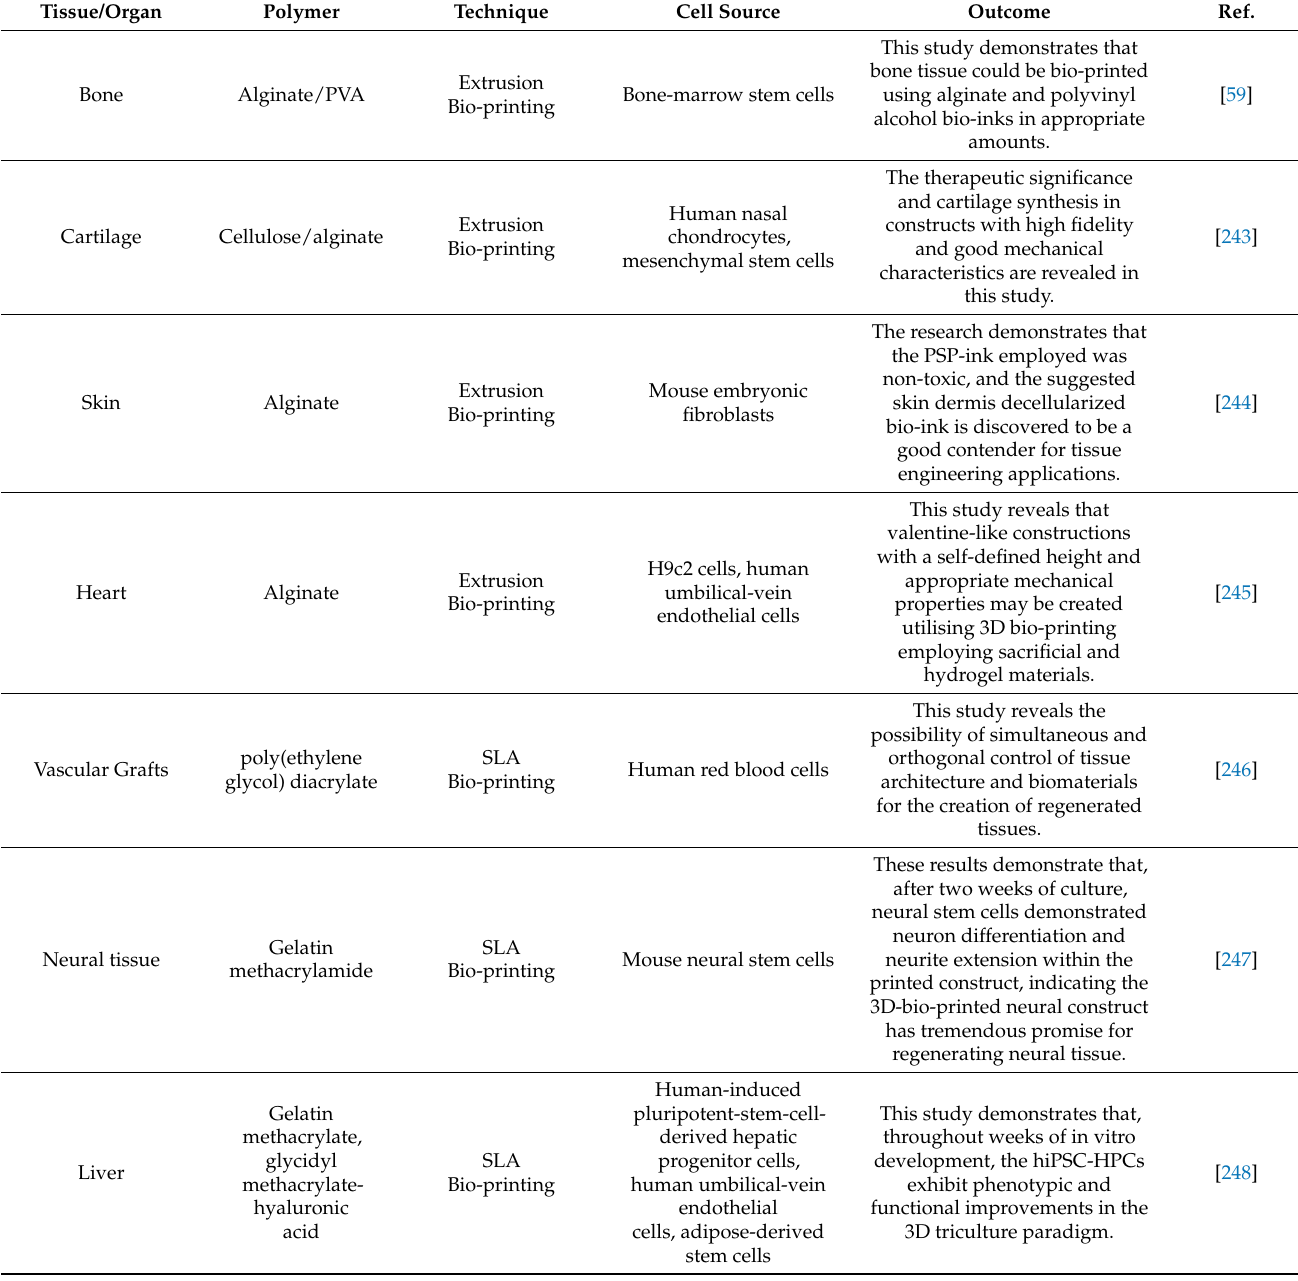
Table 3. Overview of applications of 3D bio-printing in tissue